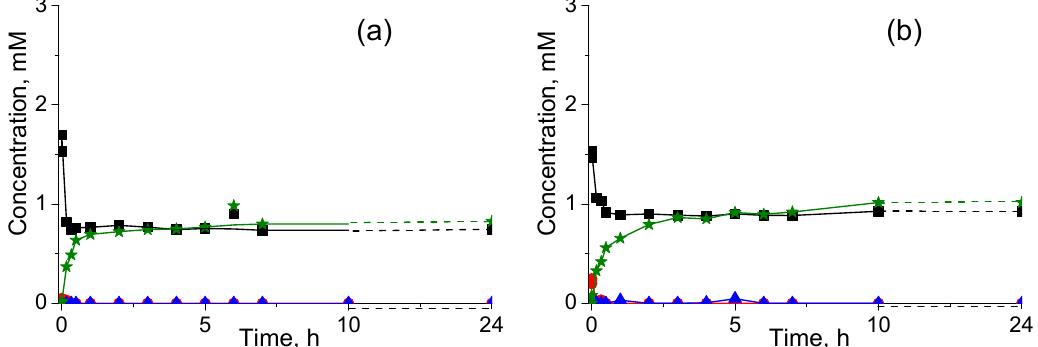
Figure 7. Concentrations of the different N-species in the presence of Pt/TiO 2 : ( a ) fresh catalyst, ( b ) used catalyst. TN ( ■ ), ammonium ( • ), nitrite ( ▲ ), nitrate ( ).